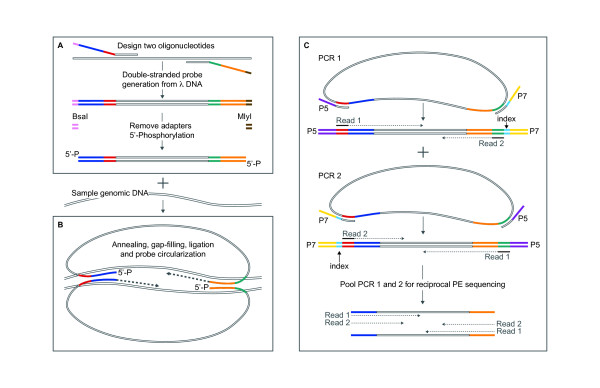
Probe construction, target capture and reciprocal paired-end sequencing.
(a) Each cLPP contains a common linker flanked by post-capture
amplification sites (red and green) and two target-specific capturing arms
(blue and orange). Probe ends are trimmed (BsaI and MlyI) and 5'-phosphorylated
to produce functional cLPPs. (b) Multiplex probe-target hybridization
followed by gap-filling and ligation triggers probe circularization and target
capture. (c) Capture libraries are multiplex-amplified using hybrid
primers that anneal to the probes' amplification sites and add Illumina
sequencing adaptors (P5 or P7) and sample-specific barcodes. This is done in
two separate PCRs during which the adaptors swap positions at the ends of
templates. Both PCRs are pooled for reciprocal PE sequencing of both DNA
strands.